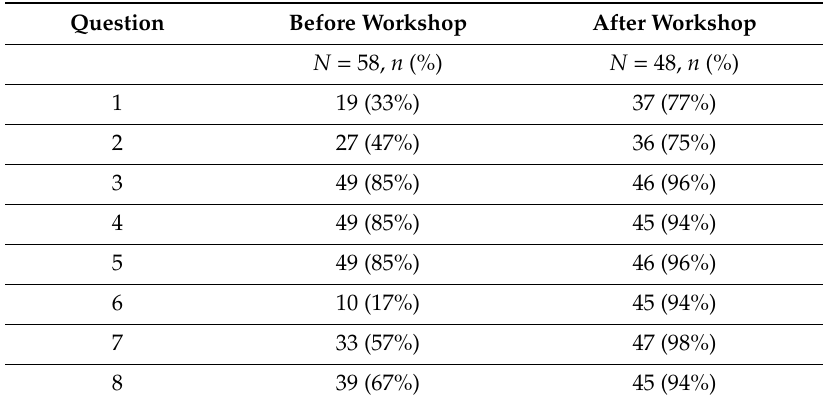
Table 3. All participants in the workshops answered a questionnaire before and after the workshop. N is the sum of total answers of the questionnaire, and n (%) is the response rate and is the sum of options 4 and 5 in the